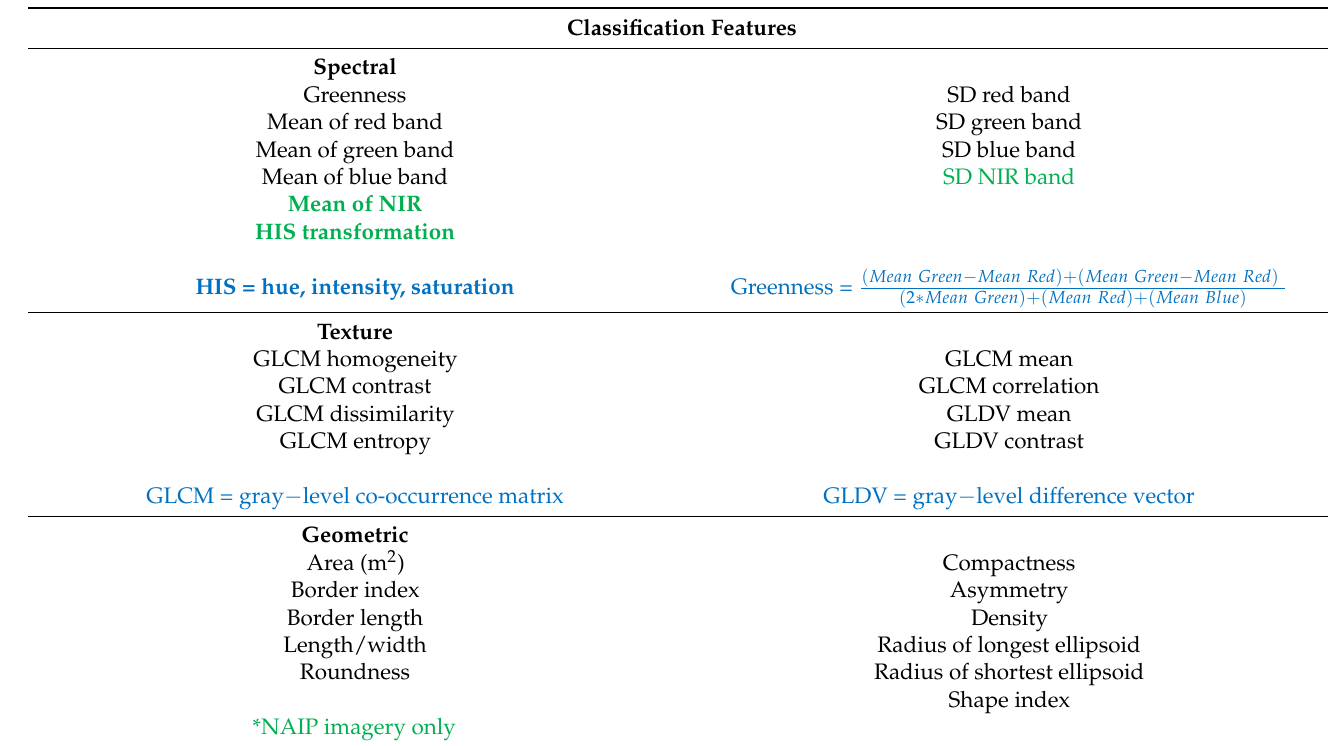
Table A1. Classification features (i.e., attributes or variables) used for the supervised classification of the NAIP (29 total) and UAS (26 total) imagery.